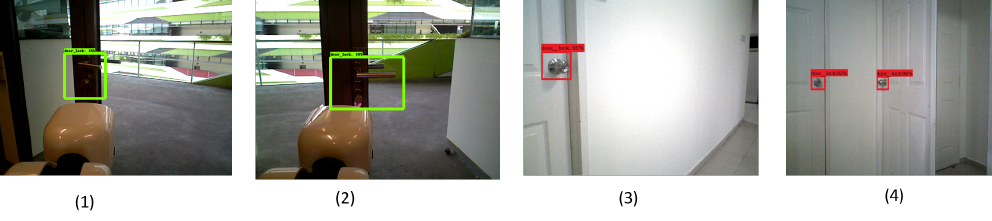
Figure 9. Real-time door-handle detection—(1, 2 Test bed1), (3, 4 Test